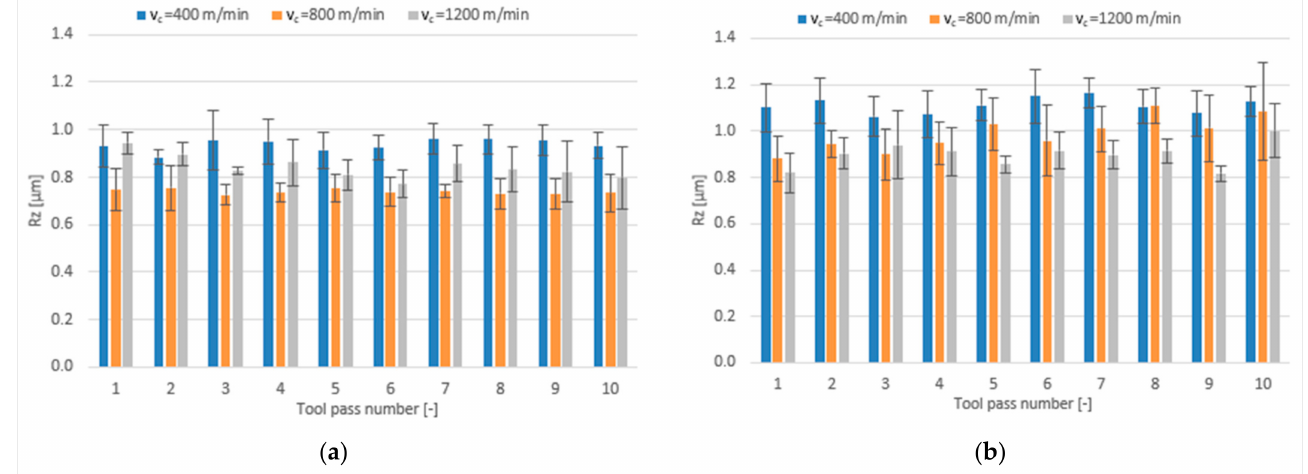
Figure 10. Cutting speed v c versus surface roughness parameter Rz in the milling process performed using a tool coated with: ( a ) TiB 2 and ( b ) TiAlN; (f z = 5 µ m/tooth; a p = 80 µ m).